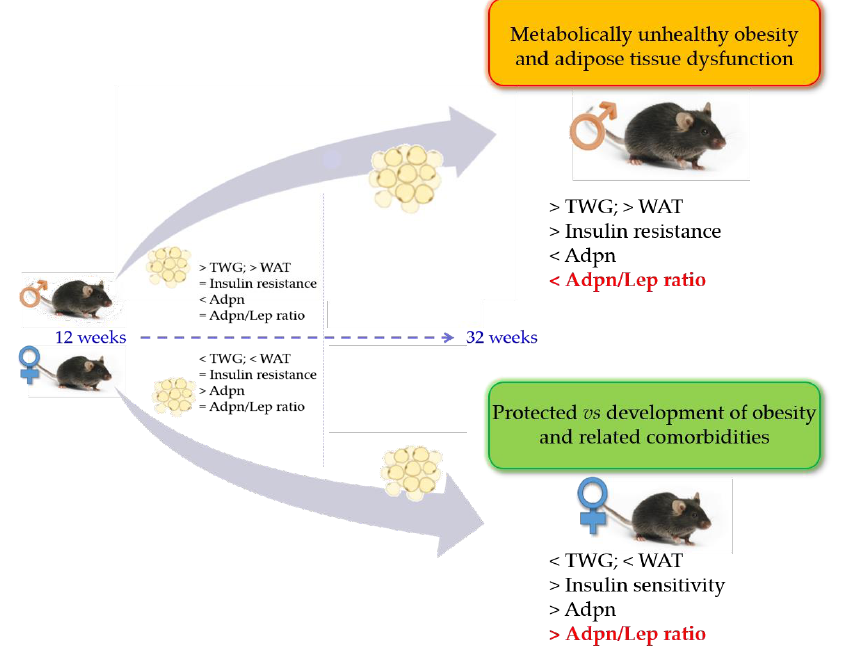
Figure 6. Impact of aging and sex in Adpn/Lep ratio on HFD-induced metabolic effects. Adpn, adiponectin; Adpn/Lep ratio, adiponectin/leptin ratio; TWG, total weight gain; WAT, white adipose tissue.